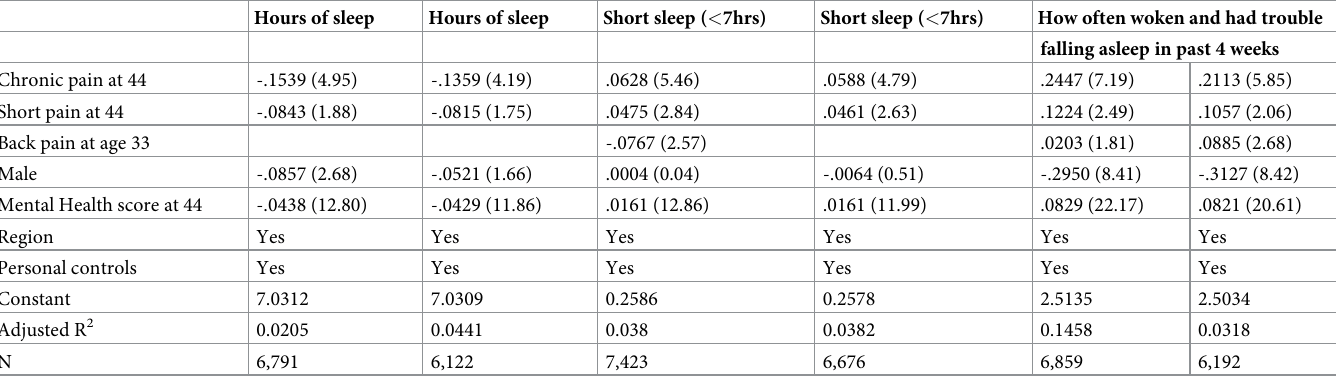
Table 16. Hours of sleep and short sleep and problems falling asleep in NCDS8 at 50.